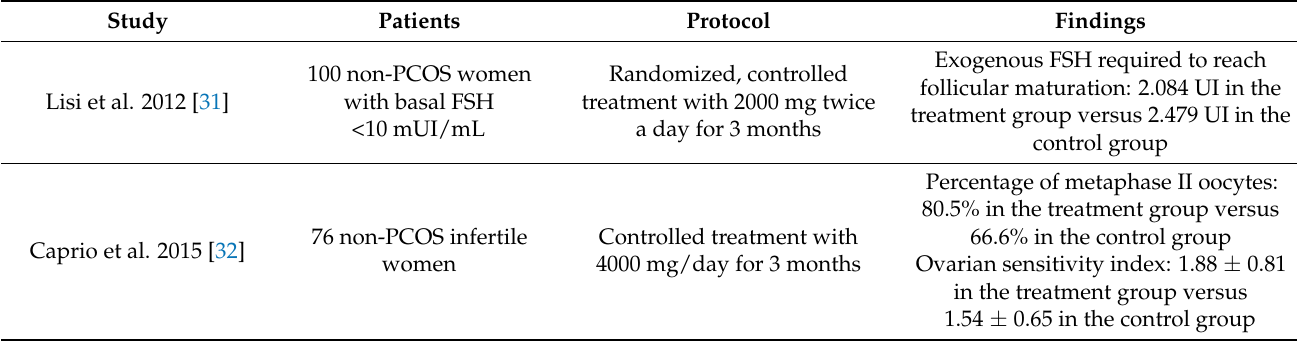
Table 2. Summary of the studies involving myo-inositol as a pretreatment for women undergoing IVF. Study